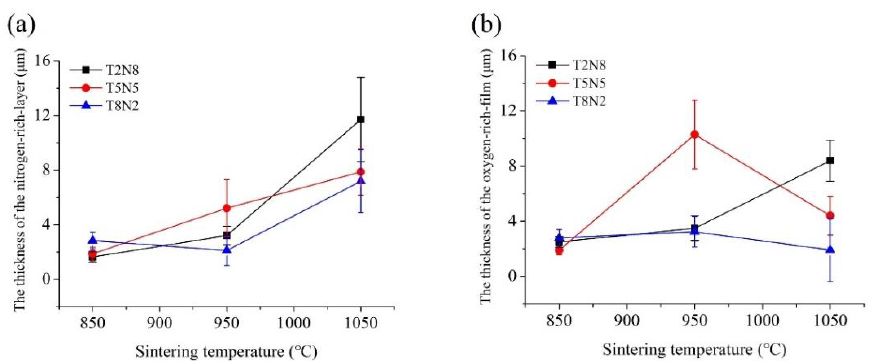
Figure 2. ( a ) Thickness of the nitrogen-rich layer of the titanium nitride particles. ( b ) Thickness of the oxygen-rich film between the titanium nitride particles and the nickel matrix.